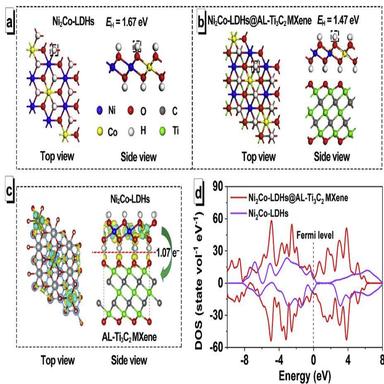
Optimized structures of (a) the pure Ni2Co-LDHs and (b) the Ni2Co-LDHs@AL-Ti3C2 MXene for the calculation of hydrogen desorption energies (EH). (c) Charge difference distribution in the flexible/stiff interface with an isosurface level of 5 104 e/Bohr3 . (d) DOS of the Ni2Co-LDHs@AL-Ti3C2 MXene composite and pure Ni2Co-LDHs.